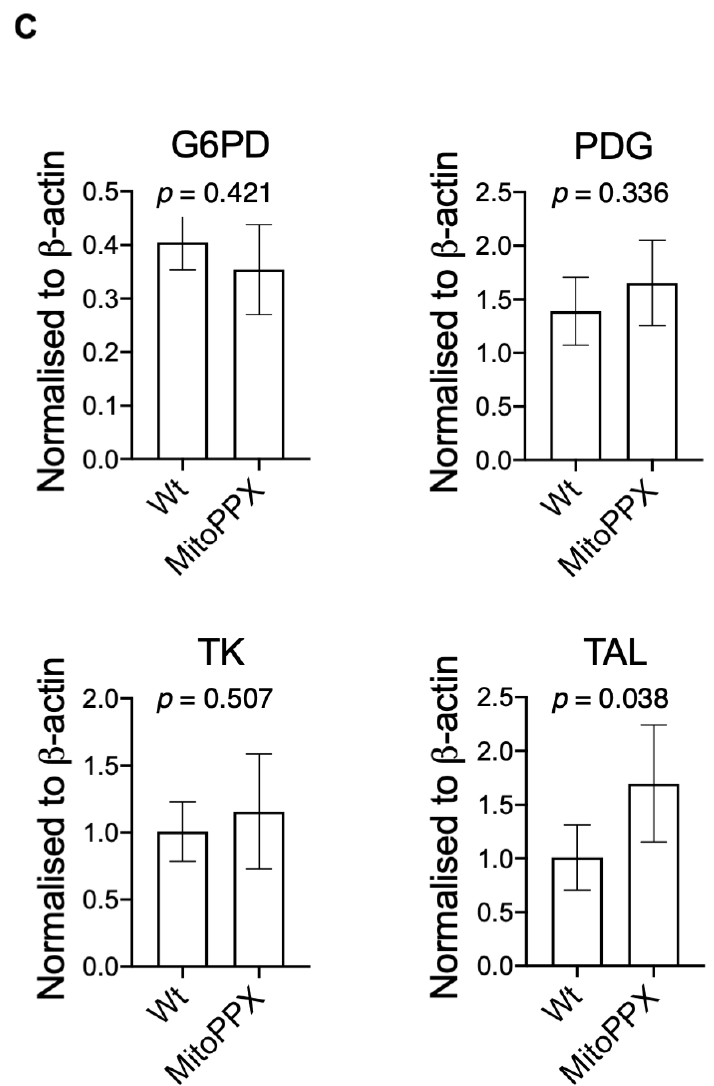
Figure 4. Mitochondrial depletion of polyP increases the protein levels of TAL. ( A ) Graph showing the percentage of glucose flux through the PPP, measured using NMR, in Wt and MitoPPX cells. Data in all graphs are shown as average ± standard deviation of four independent NMR experiments, which were conducted with samples obtained on four separate days. Unpaired t-tests were used to detect significant differences between Wt and MitoPPX cells. ( B ) Non-reducing immunoblotting was performed to detect the basal levels of G6PD and PGD (oxidative phase of the PPP) and TK and TAL (non-oxidative phase of the PPP) in Wt and MitoPPX cells. Representative immunoblots are shown. β -actin was used as a loading control. ( C ) Densitometric analysis of basal G6PD, PGD, TK, and TAL protein levels. Data shown as mean ± standard deviation from n = 3 independent experiments are presented. Unpaired t-tests were used to detect significant differences between Wt and MitoPPX cells. Abbreviations used in this figure: TAL: transaldolase; PPP: pentose phosphate path-